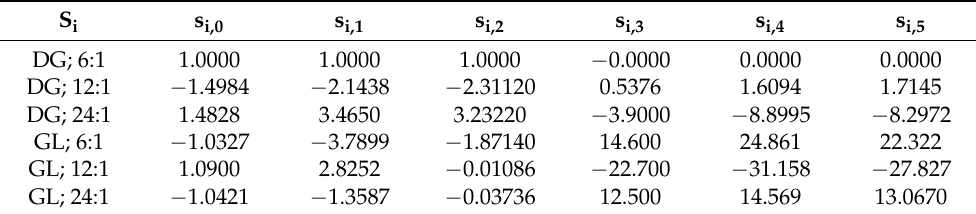
Table 2. Selectivity coefficients obtained for diglycerides (DG) and glycerol (GL) for selected